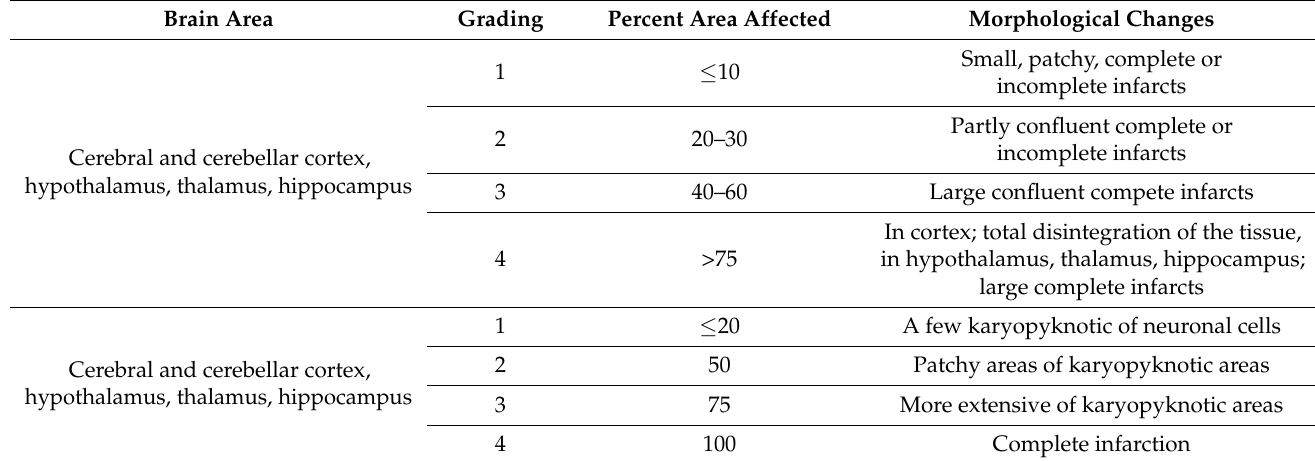
Table 1. The neuropathologic